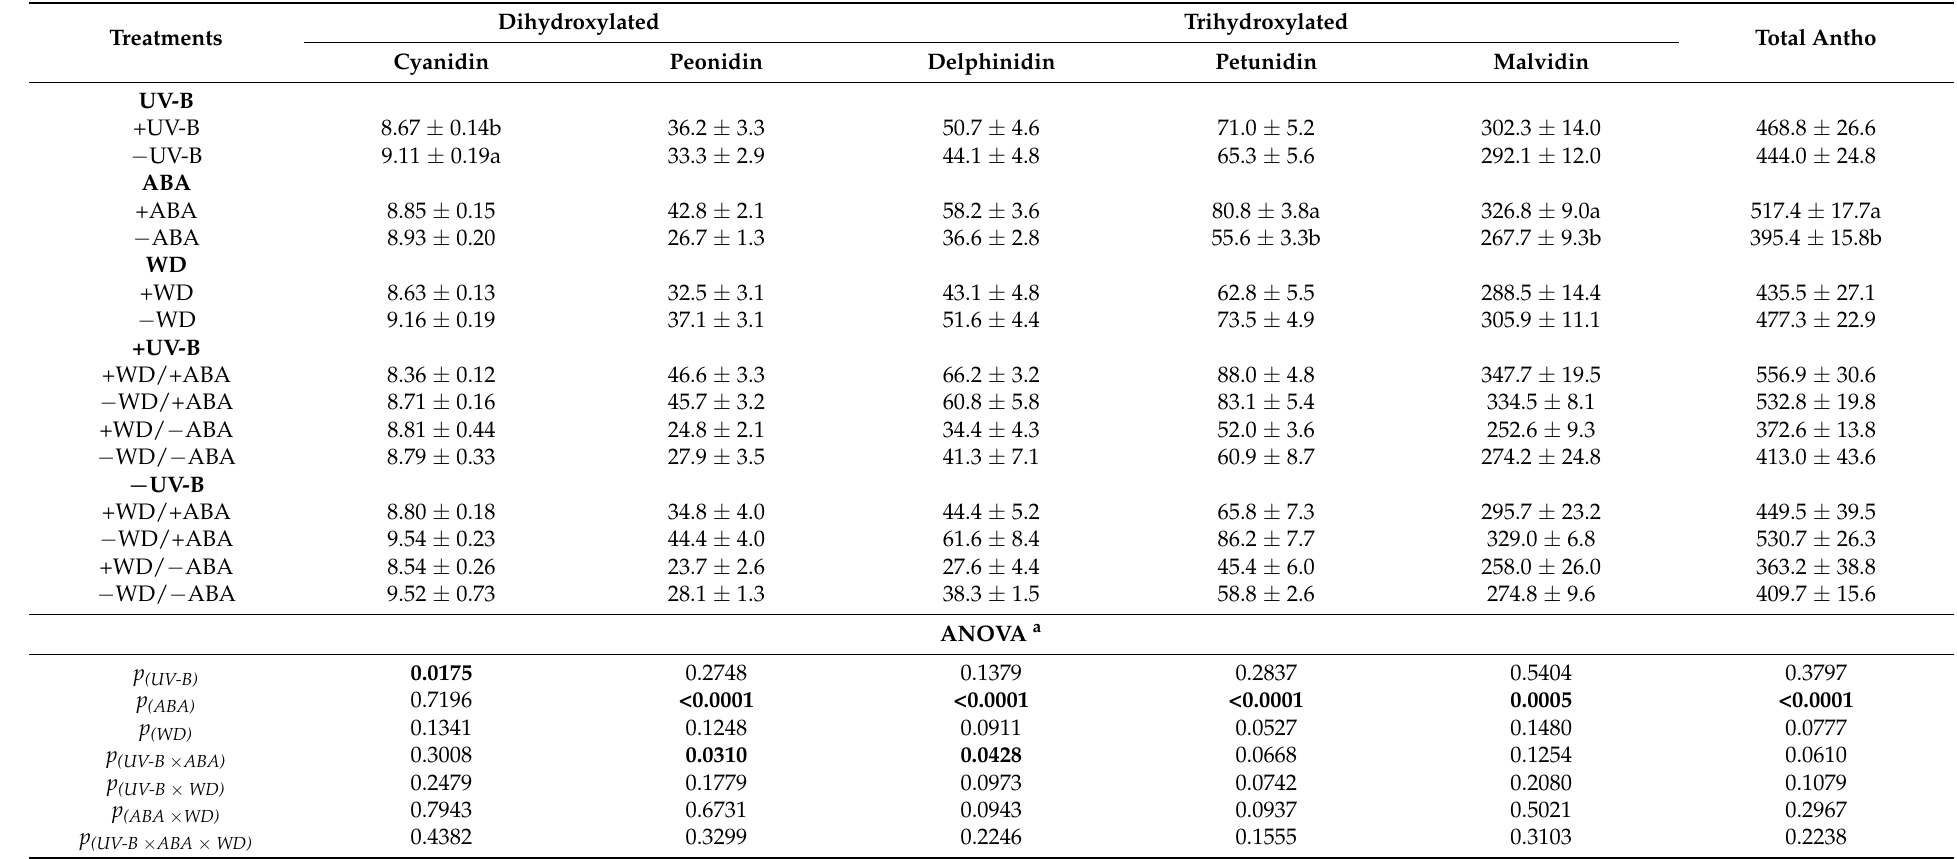
Table 2. Anthocyanin content (mg L − 1 ) determined in wines from Malbec plants exposed to combined UV-B, WD and ABA treatments.